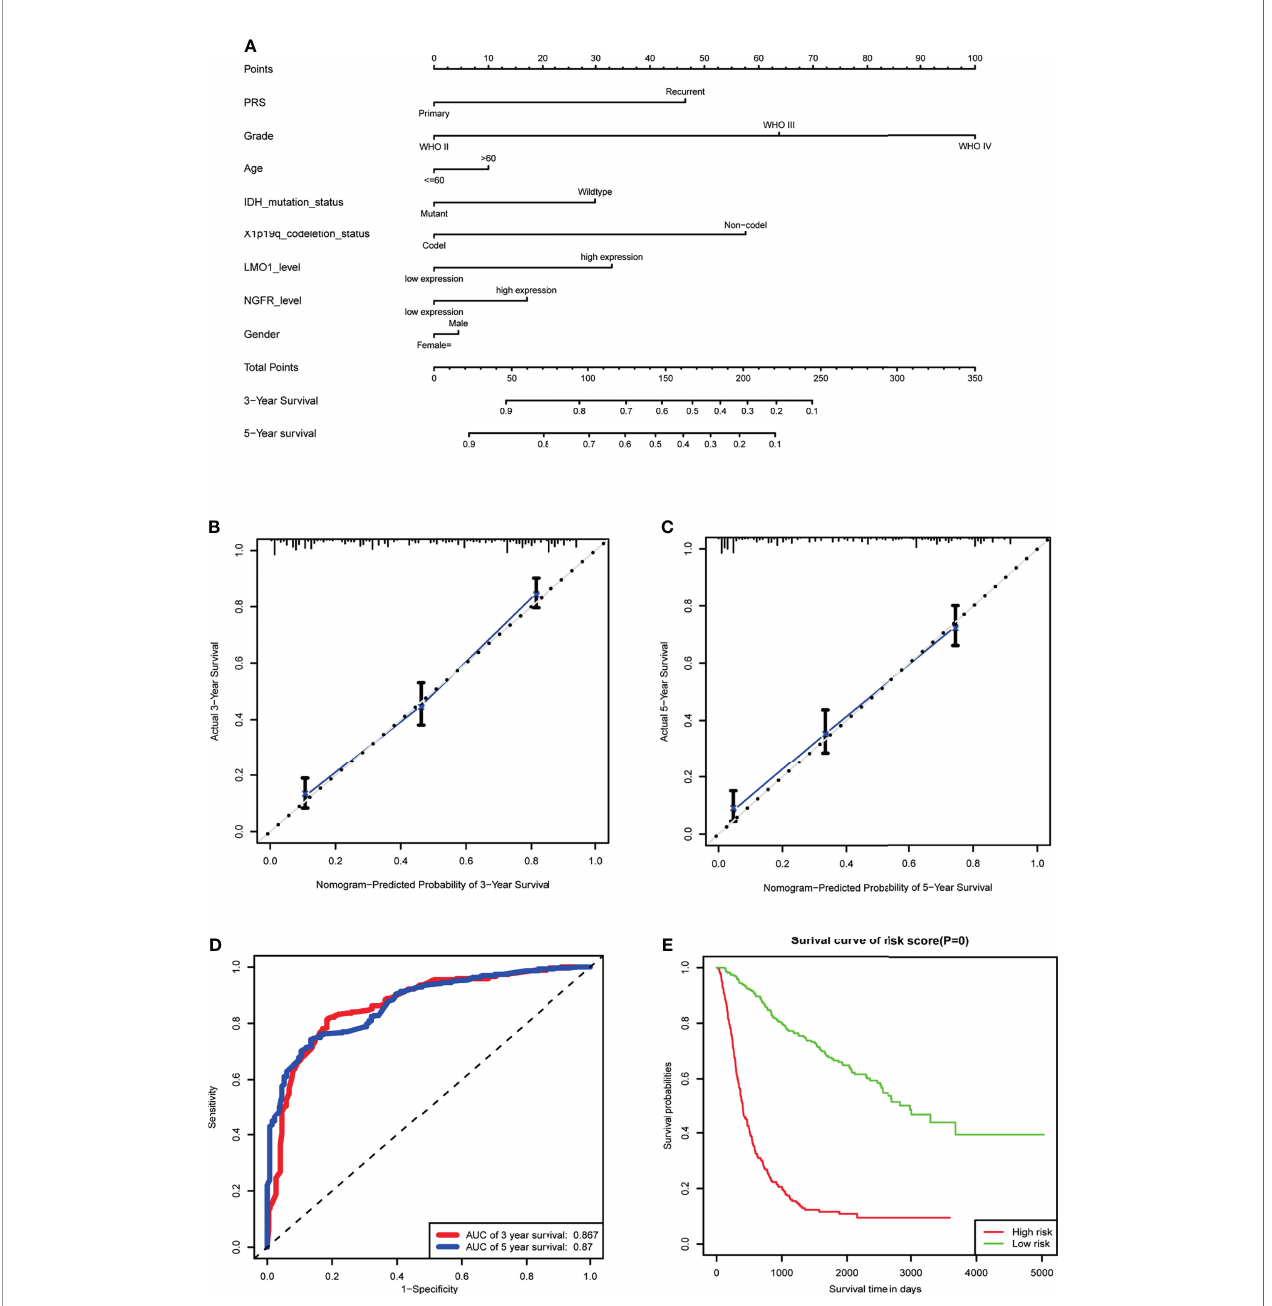
FIGURE 7 | Establishment of the overall survival nomogram for human glioma patients using the CGGA dataset. (A) Nomogram for predicting overall survival of human gliomas. There are seven components in this nomogram: PRS, Grade,Age, IDH Mutation Status,1p/19q Codeletion Status, LMO1 and NGFR level, and Gender. Each of them generates points according to the line drawn upward. And the total points of the seven components of an individual patient lie on “ Total Points ” axis which corresponds to the probability of 3 ‐ year and 5 ‐ year survival rate plotted on the two axes below. (B, C) Calibration plots of the nomogram for predicting overall survival rate at 3 year (B) and 5 years (C) . The predicted and the actual probabilities of overall survival were plotted on the x ‐ and y ‐ axis, respectively. (D) ROC curve showing the sensitivity of the program. (E) Kaplan ‐ Meier curves of two risk subgroups strati fi ed by the total points the nomogram